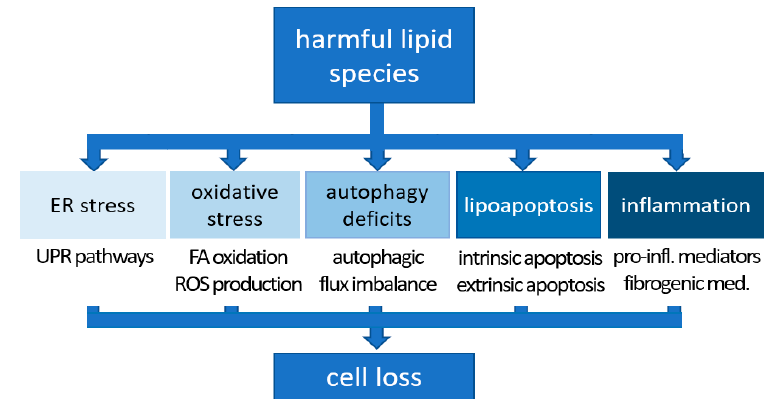
Figure 1. Lipotoxicity mechanisms. Lipid-excess-induced lipotoxicity causes ER stress, oxidative stress, autophagy impairment, lipoapoptosis and inflammation (adapted from [34] under a Creative Commons Attribution 4.0 International License: https://creativecommons.org/licenses/by/4.0/, accessed on 21 November 2021).